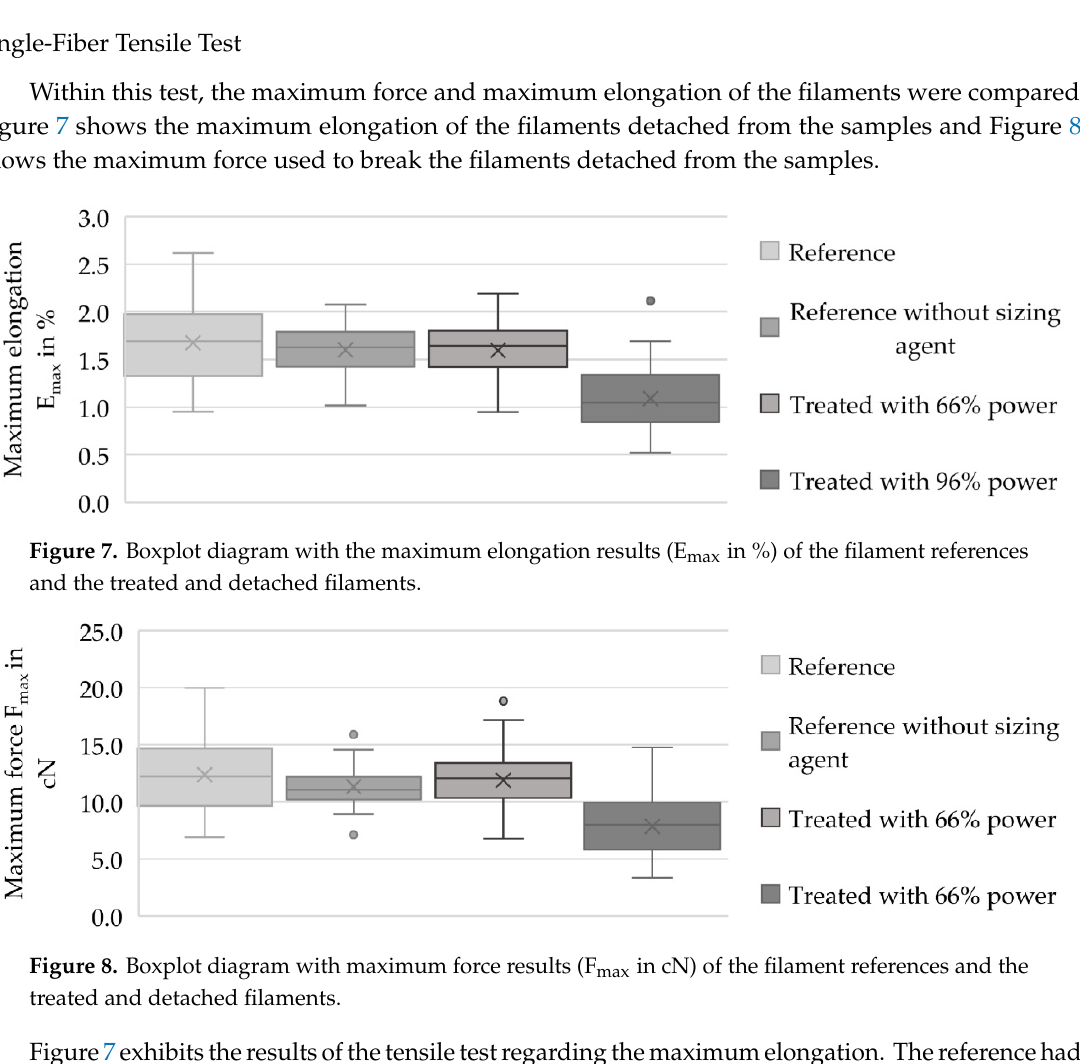
Figure 6. Polished micrograph section of a four-layered carbon-fiber-reinforced plastic (CFRP) sample treated with 66% power.